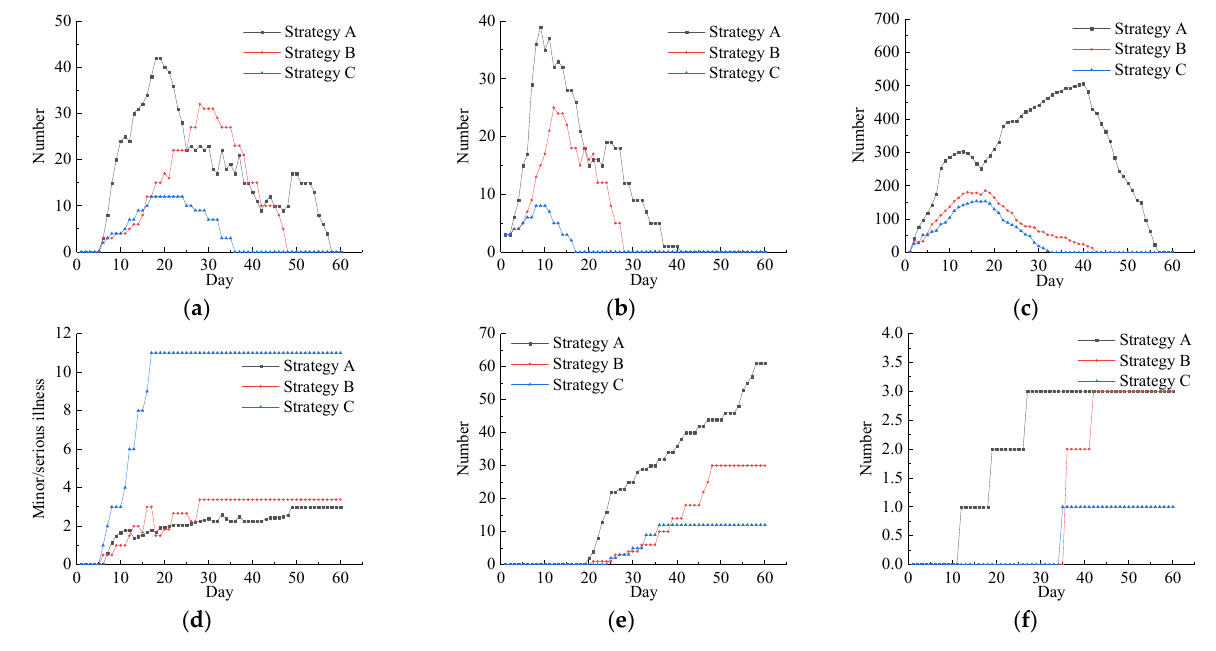
Figure 9. Comprehensive intervention level adjustment scenarios: ( a ) changes in the number of confirmed cases, ( b ) changes in the number of lurkers, ( c ) changes in the number of close contacts, ( d ) mild-to-severe-disease ratio, ( e ) changes in the cumulative number of cured patients, ( f ) cumula- tive number of